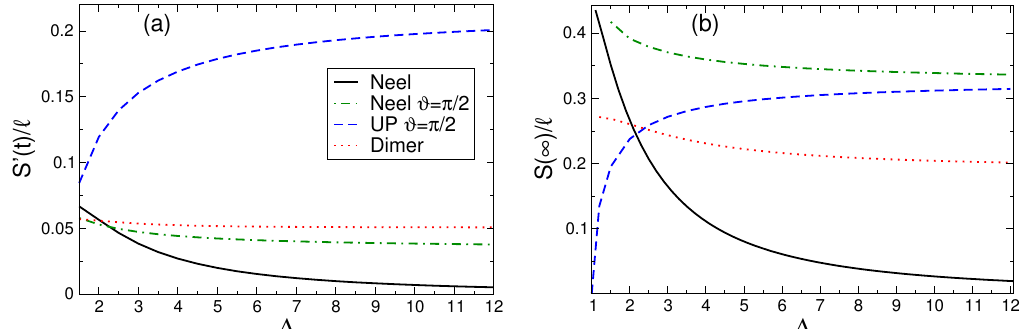
Figure 6: Anisotropy dependence of the entanglement after a global quench in the XXZ chains. Panel (a). The entanglement production rate S (cid:48) ( t ) /(cid:96) as function of ∆ . Different curves correspond to different initial states. Panel (b). Steady-state entanglement entropy density S ( t = ∞ ) /(cid:96) after the quench. The entanglement is identically zero in the limit ∆ → ∞